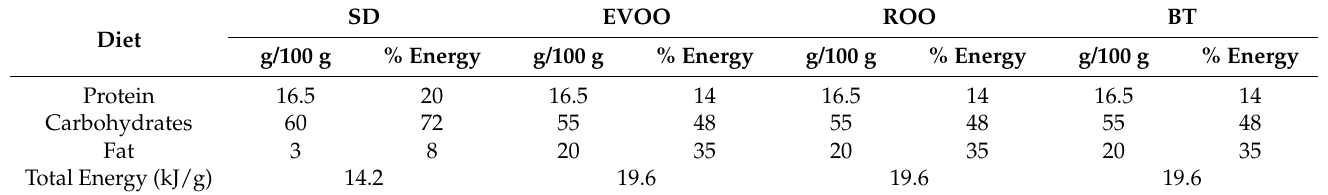
Table 3. Nutrient composition and energy content of standard (SD) and high-fat diets enriched with extra virgin olive oil (EVOO), refined olive oil (ROO), and butter (BT)